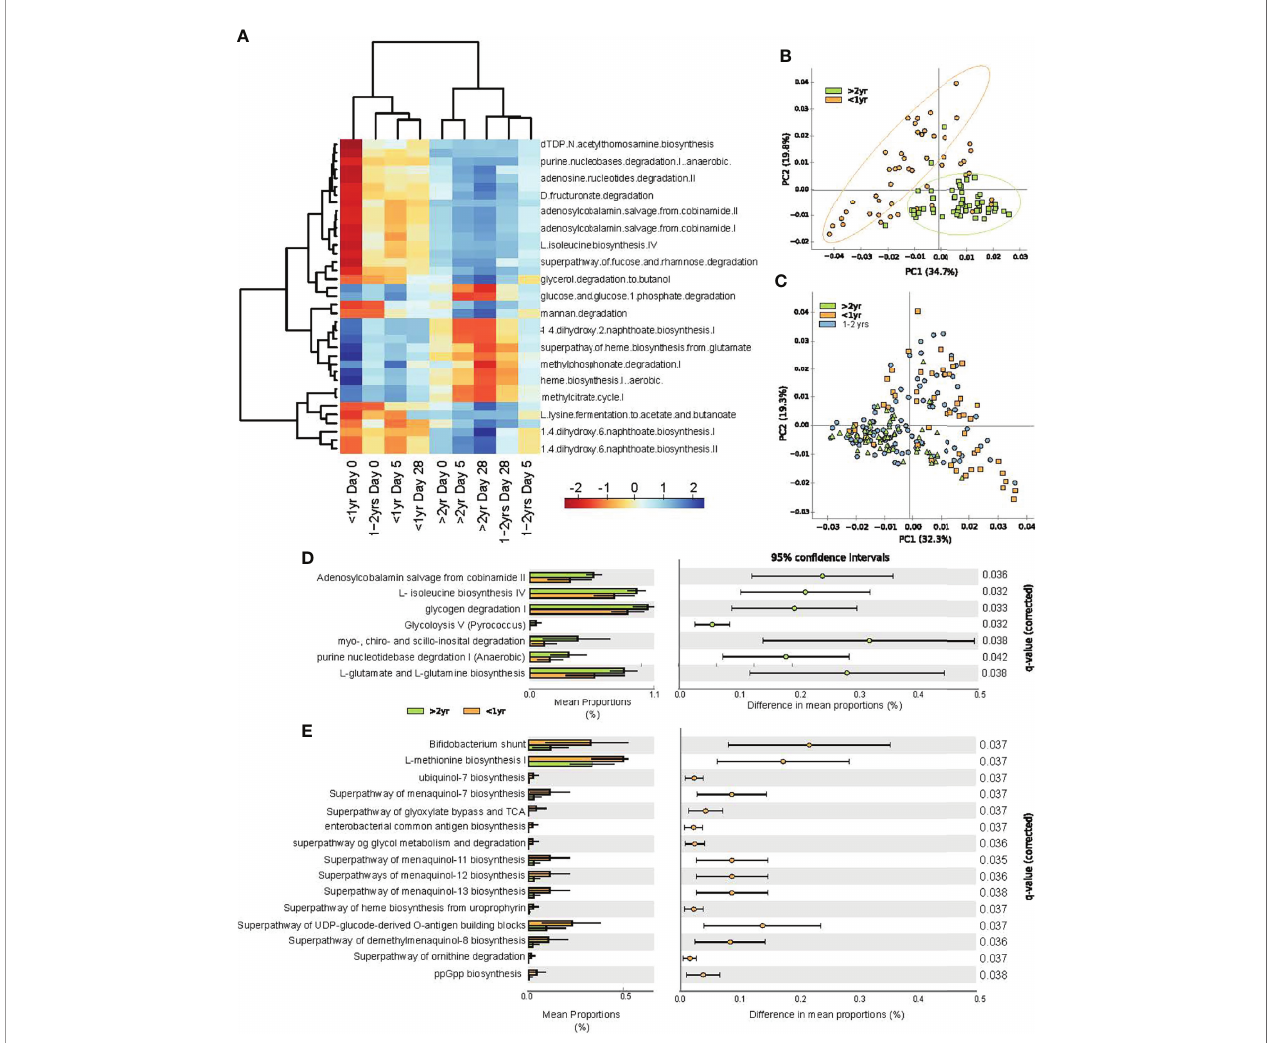
FIGURE 5 | Predicted functional changes in gut bacteria across study periods and between age categories. (A) heat map of center log ratio normalized abundance of functional pathways were signi fi cantly associated with participant age category and sampling day, as determined by linear mixed model regression; (B) principal component analysis of predicted functional pathways at all sampling time points for study participants <1.0 year and those >2.0 - <4.0 years of age; (C) principal component analysis of all subjects at all time points; (D) extended error plot of abundance of functional pathways greater in children >2.0 - <4.0 years old compared to those <1.0 year; and (E) extended error plot of abundance of functional pathways, which were increase in infants <1.0 year. Statistical signi fi cance was assessed by one-sided Welch ’ s t-test, with multiple comparisons corrected by